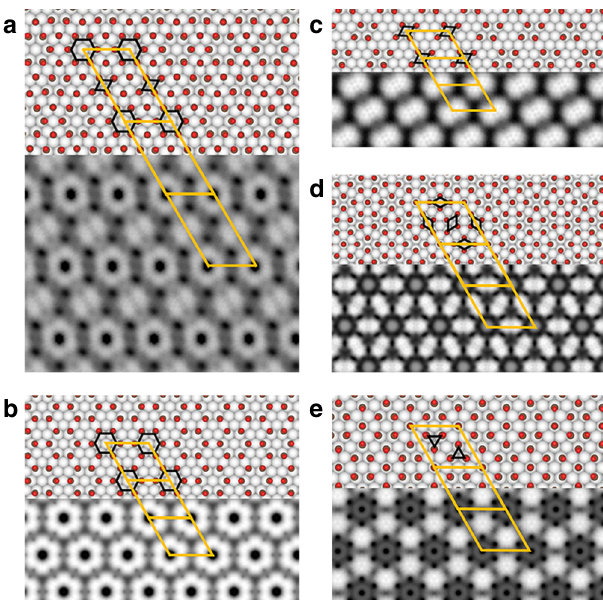
Fig. 2 Atomic structural models and corresponding STM simulations. a 4 × 7 superlattice of α phase. b 4 × 4 superlattice of α phase. c 4 × 3 superlattice of α phase. d (3 √ 3 × 3 √ 3)R30° superlattice of β phase. e 4 × 4 superlattice of γ phase. Red, brown, and gray balls in models represent oxygen, carbon, and copper atoms, respectively. The orange parallelograms and rhombuses represent the unit cells of these phases. The dark blue hexagons, rhombuses, and triangles highlight